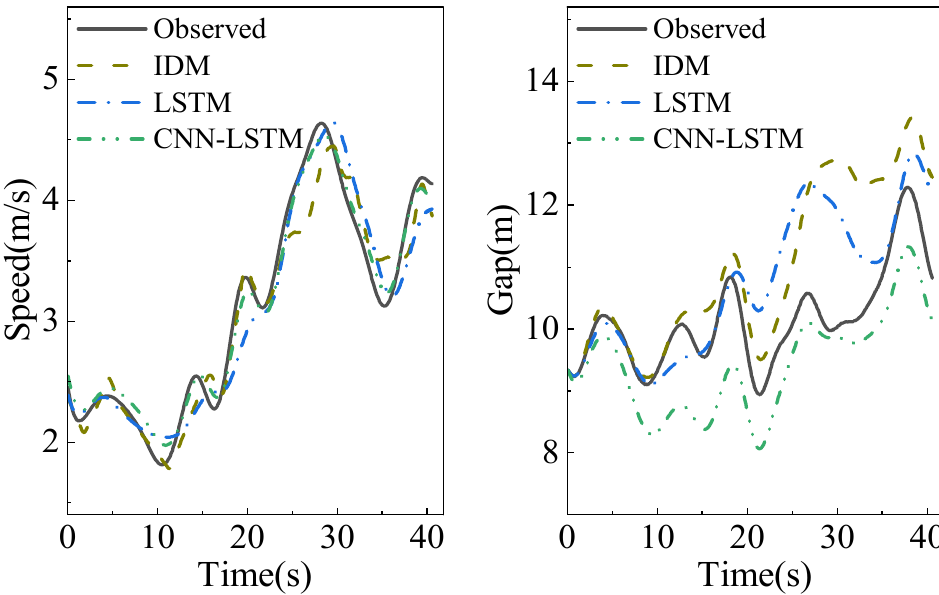
Figure 6. Performance comparison of 3 models. Heterogeneity includes the heterogeneity of driving behavior (different driving styles) and the heterogeneity of drivers (human, ACC system). We adopted the K -means algorithm to cluster the mean gap and the standard deviation of the following vehicles’ speeds. The driving styles are divided into aggressive and normal [12]. We randomly selected the periods of two driving types from the test dataset. The experimental results are shown in Figures 7 and 8. Due to error accumulation, the IDM generates significant gap errors in the later stage of the car-following process. The deep learning car-following model is good at learning and summarizing the rules of the trajectories data, resulting in a small error between the generated trajectories and the observed trajectories, indicating that the deep learning algorithm has a strong ability to learn heterogeneous driving behaviors. Compared with the LSTM model with the same configuration and parameters, the CNN-LSTM model can reduce the trajectory prediction error by 54.9% and 62.2%, respectively. Moreover, it can reduce the running time by 60.8% compared with the LSTM model, which verifies the effectiveness of the CNN in the feature extraction of car-following behavior. It is known from the generalized force model that the driver of the following vehicle expects to keep a safe distance positively related to the speed of his vehicle with the leading vehicle during car-following [22]. As shown in formula (10), we employ it as the safety distance, and the time headway corresponding to different driving styles. Each model’s simulation gap and the safe distance are shown in the fourth subgraphs of Figures 7 and 8. All models cannot guarantee that the simulation gap is higher than the safe distance, but the simulation gap generated by the CNN-LSTM model is the closest to the safe distance, which indicates that the proposed model can better reproduce the driver’s expected following behavior.